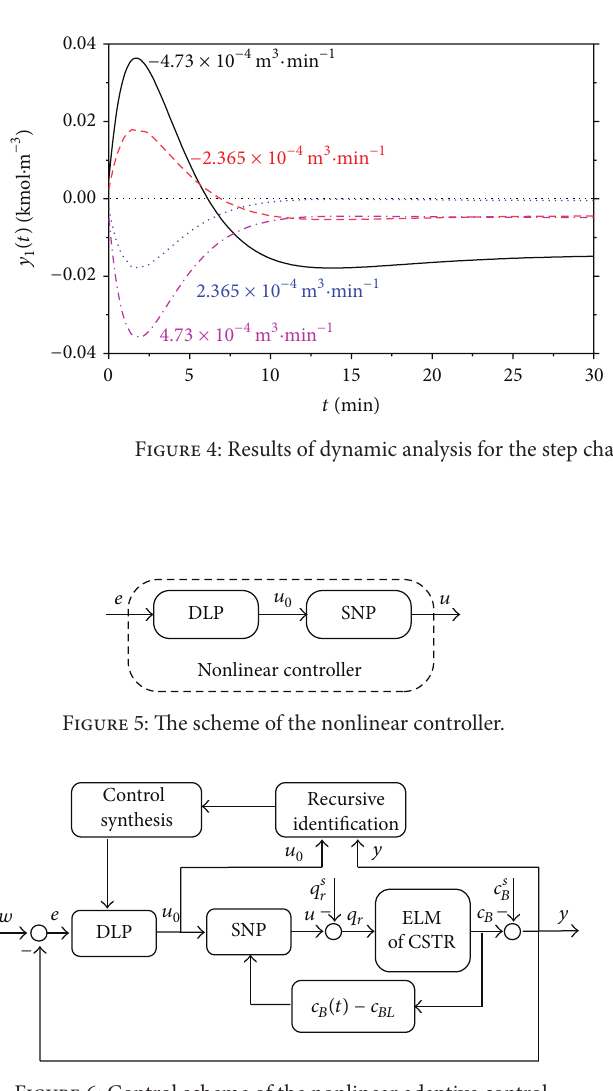
Figure 3: Results of dynamic analysis for the step changes of the heat removal of the cooling, Δ𝑄 𝑐 .